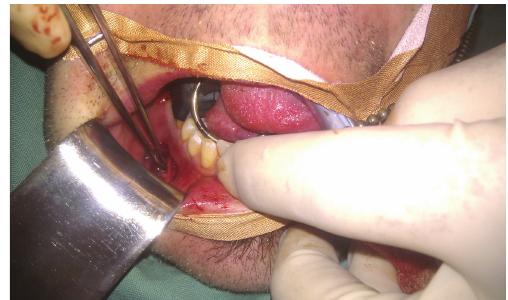
F 2: Photograph showing intraoperative �ndings of implant pressing on mental nerve.